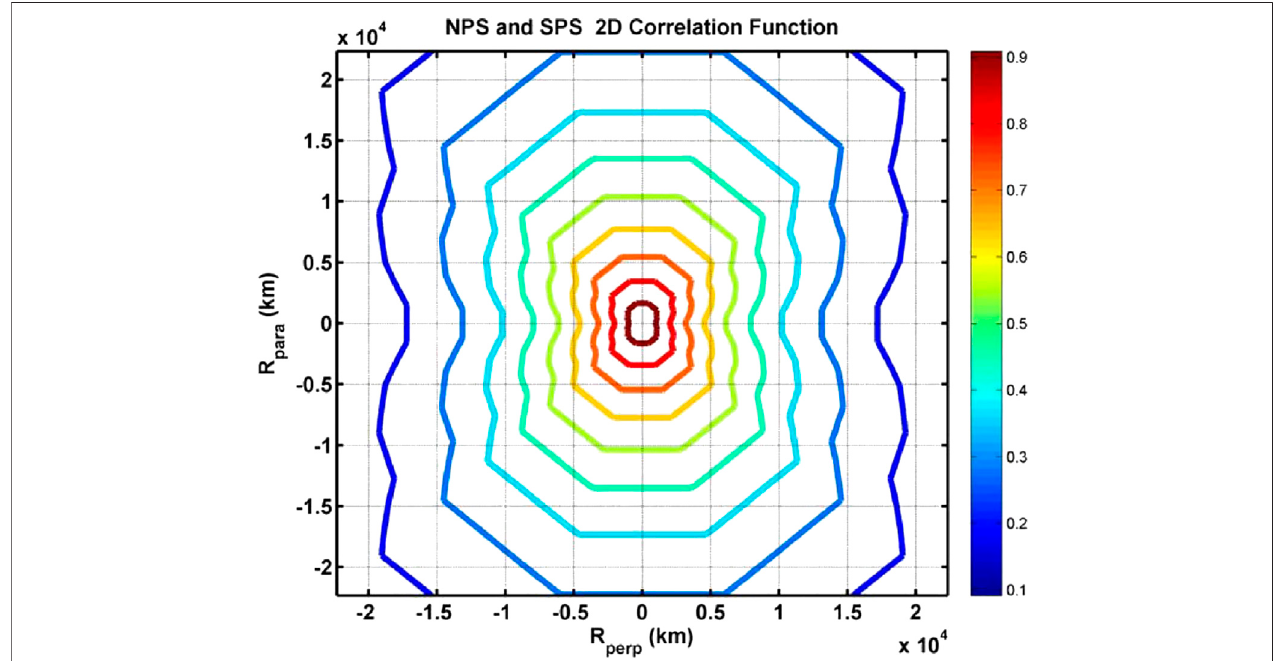
FIGURE 2 | Correlation contour plot for the plasma sheet. Correlations calculated for one quadrant were mirrored into the other quadrants. Rperp is the separation perpendiculartothemeanmagnetic fi elddirectionandRparaistheseparationparalleltothemagnetic fi elddirection.Thecolorbargivesthevalueofthecrosscorrelationcoef fi cient (Weygand et al.,